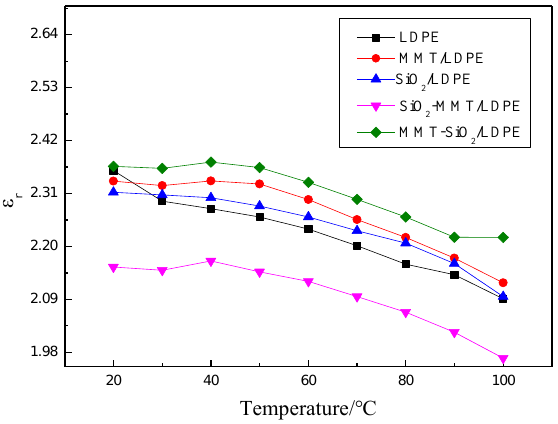
Figure 7. Curves of ε r with respect to T.